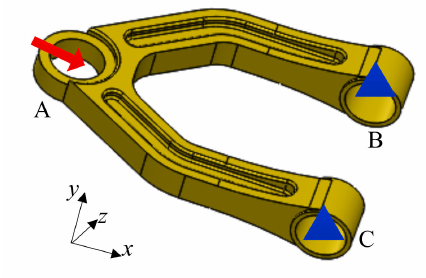
Figure 8. The control arm and boundary